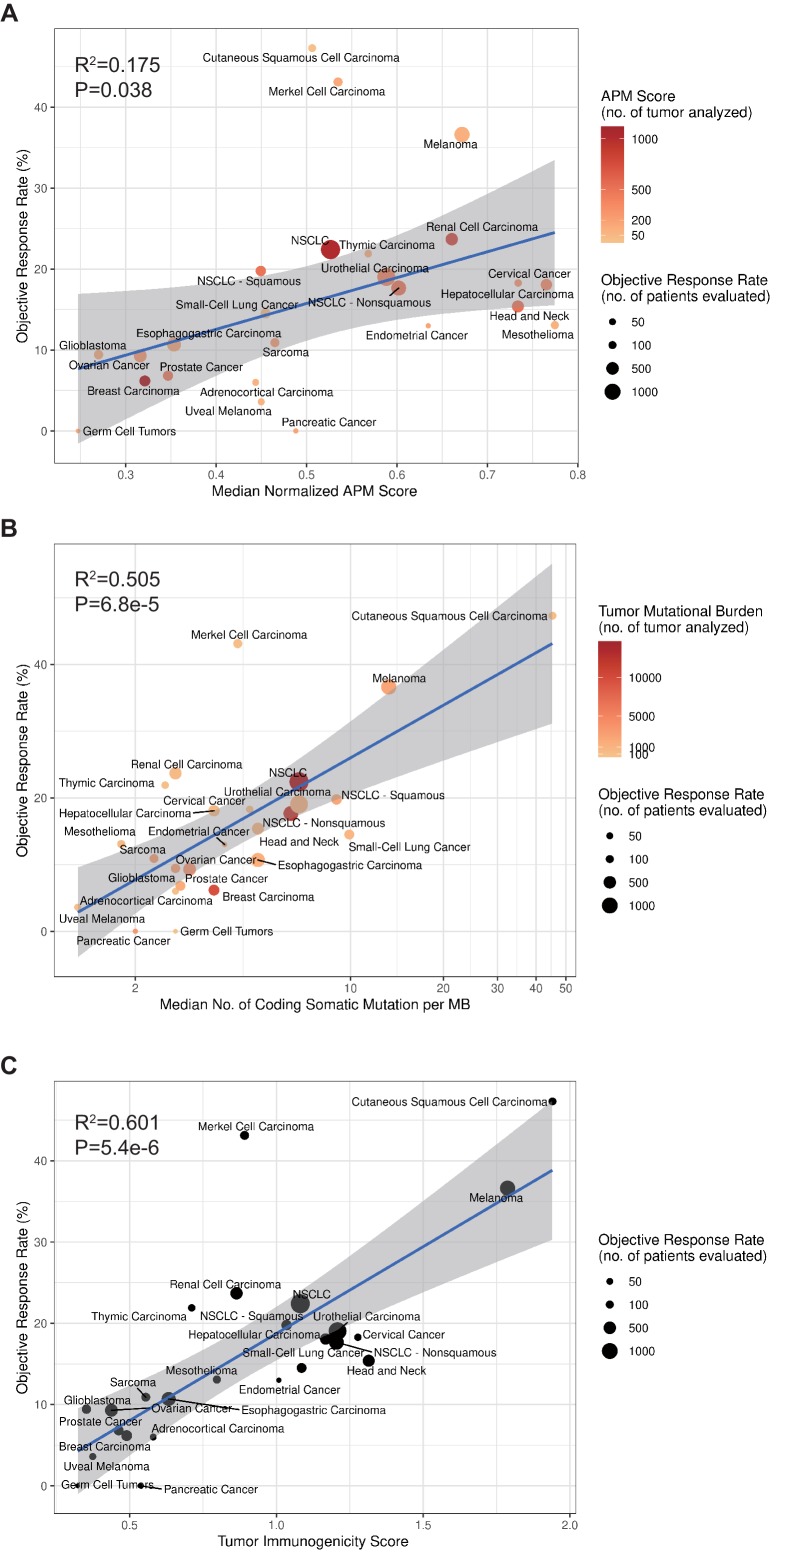
TIGS and predicted pan-cancer response rates to PD-1 inhibition.Correlation between (A) APS, (B) TMB, (C) TIGS and objective response rate (ORR) with anti-PD-1 or anti-PD-L1 therapy in 25 cancer types. Shown are median normalized APS (A), median number of TMB (non-synonymous mutation/MB) in log scale (B) and TIGS in 25 tumor types or subtypes among patients who received inhibitors of PD-1 or PD-L1 (C), as described in published studies for which data regarding the ORR are available. The number of patients who were evaluated for the ORR is shown for each tumor type (size of the circle), along with the number of tumor samples that were analyzed to calculate the APS, TMB or TIGS (degree of shading of the circle).10.7554/eLife.49020.016Figure 4—source data 1.List of citations for individual studies used in pooled analysis of objective response rate.10.7554/eLife.49020.017Figure 4—source data 2.Summary of pooled ORR, median TMB and median APS by tumor type or subtype.